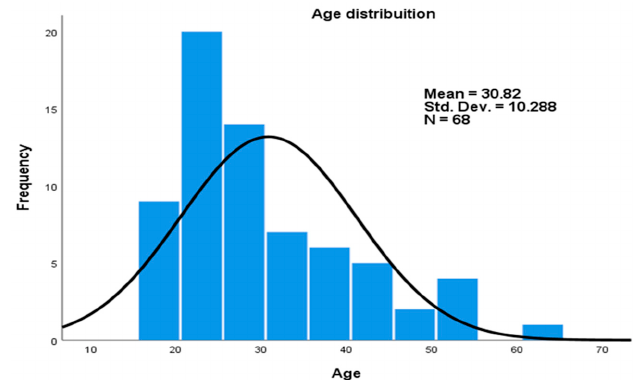
Figure 1. Age distribution of study participants.